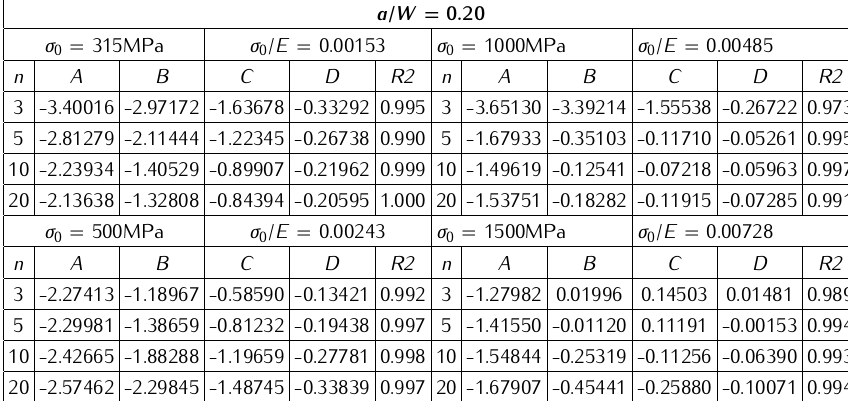
Table 5. The coefficients of equation (13) for CC(T) specimen with the crack length a / W =0.20.